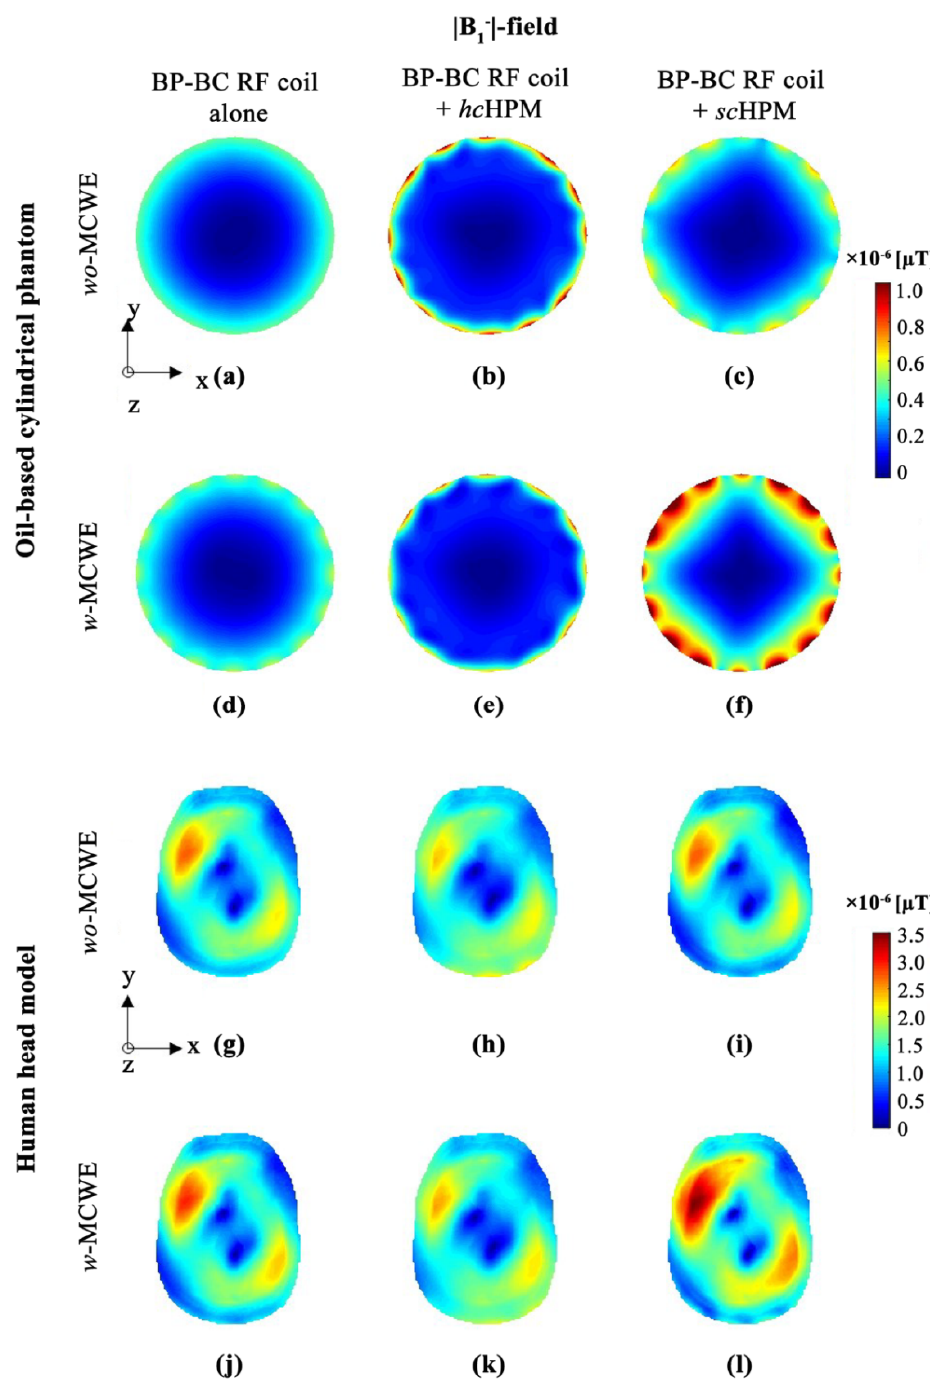
Figure 4. |B − |-field distribution in oil-based cylindrical phantom ( a – f ) or human body model ( g – l ): ( a , g ) BP-BC RF coil alone − wo -MCWE; ( b , h ) BP-BC RF coil + hc HPM − wo -MCWE; ( c , i ) BP-BC RF coil + sc HPM − wo -MCWE; ( d , j ) BP-BC RF coil alone − w -MCWE; ( e , k ) BP-BC RF coil + hc HPM − w -MCWE; ( f , l ) BP-BC RF coil + sc HPM − w -MCWE.